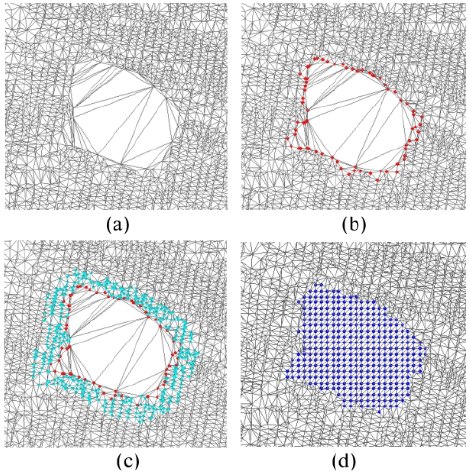
Figure 4. Algorithm processing result(a) Building a Delaunay triangulation(b) Extract the boundary (red is the boundary point)(c) Search for k-nearest neighbor points of the boundary